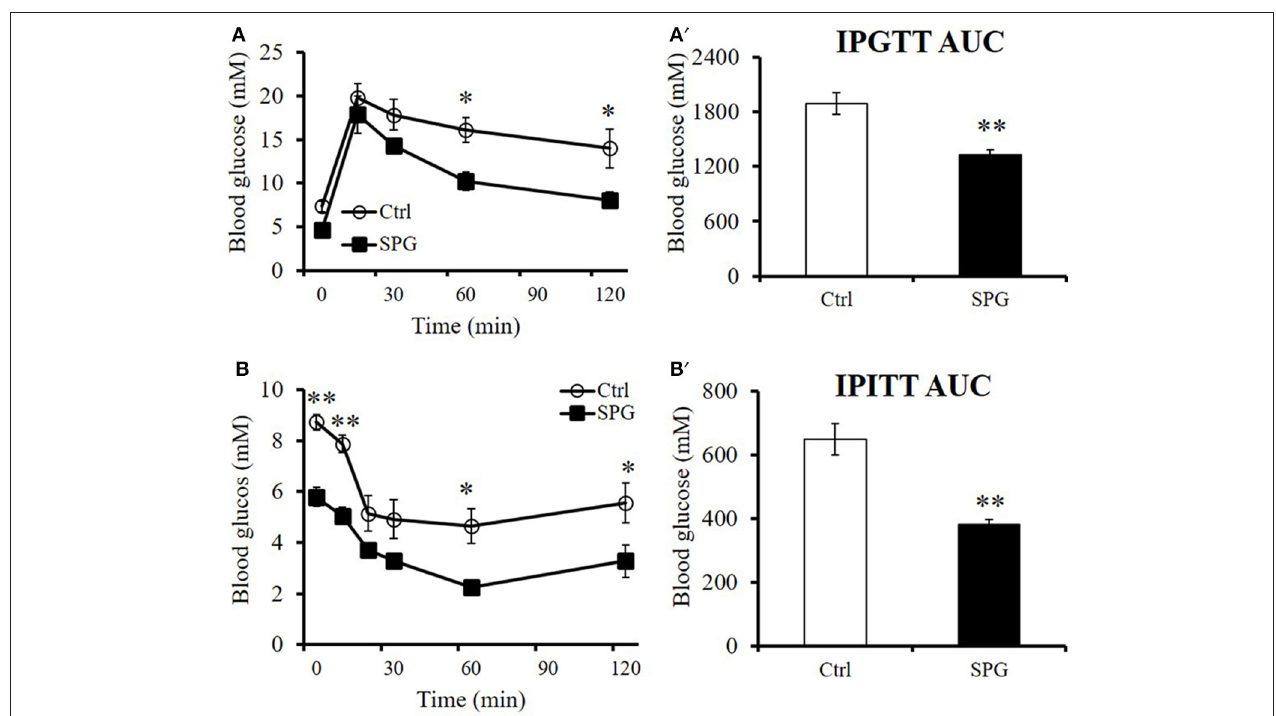
FIGURE 9 | Supaglutide improves glucose tolerance and insulin sensitivity in the DIO mice. Glucose concentrations during (A) IPGTT or (B) an insulin tolerance test (ITT) in control and supaglutide-treated mice. The significant differences between groups in (A) and (B) are analyzed using two-way RM ANOVA method. Area under curve (AUC) for (A’) IPGTT and (B’) ITT were calculated. The significant differences between groups in (A’) and (B’) are analyzed using unpaired Student’s t -test. All values are means ± SE ( n = 5 for each group). * p < 0.05; ** p <